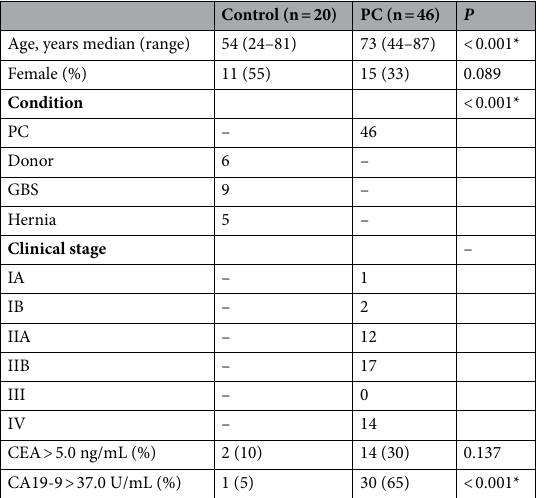
Table 1. Characteristics of patients enrolled in our study. PC pancreatic cancer, GBS gallbladder stones, CEA carcinoembryonic antigen, CA19-9 carbohydrate antigen